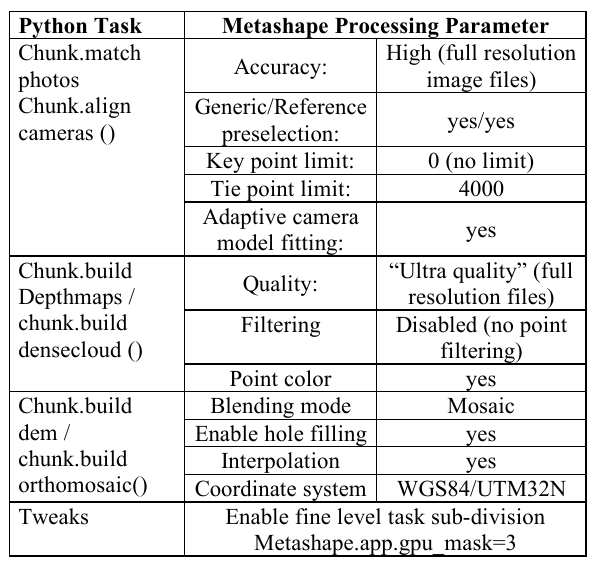
Table 2. Agisoft Metashape 1.5.1. cluster processing setup for